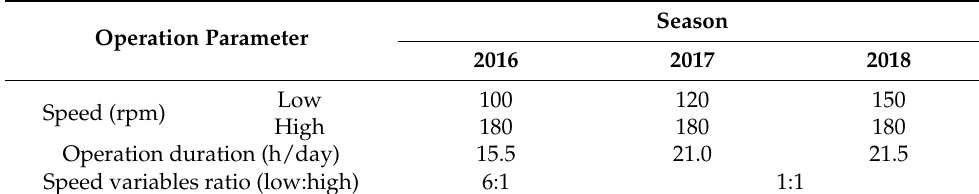
Table 1. Operation conditions of the convectional water circulation system.